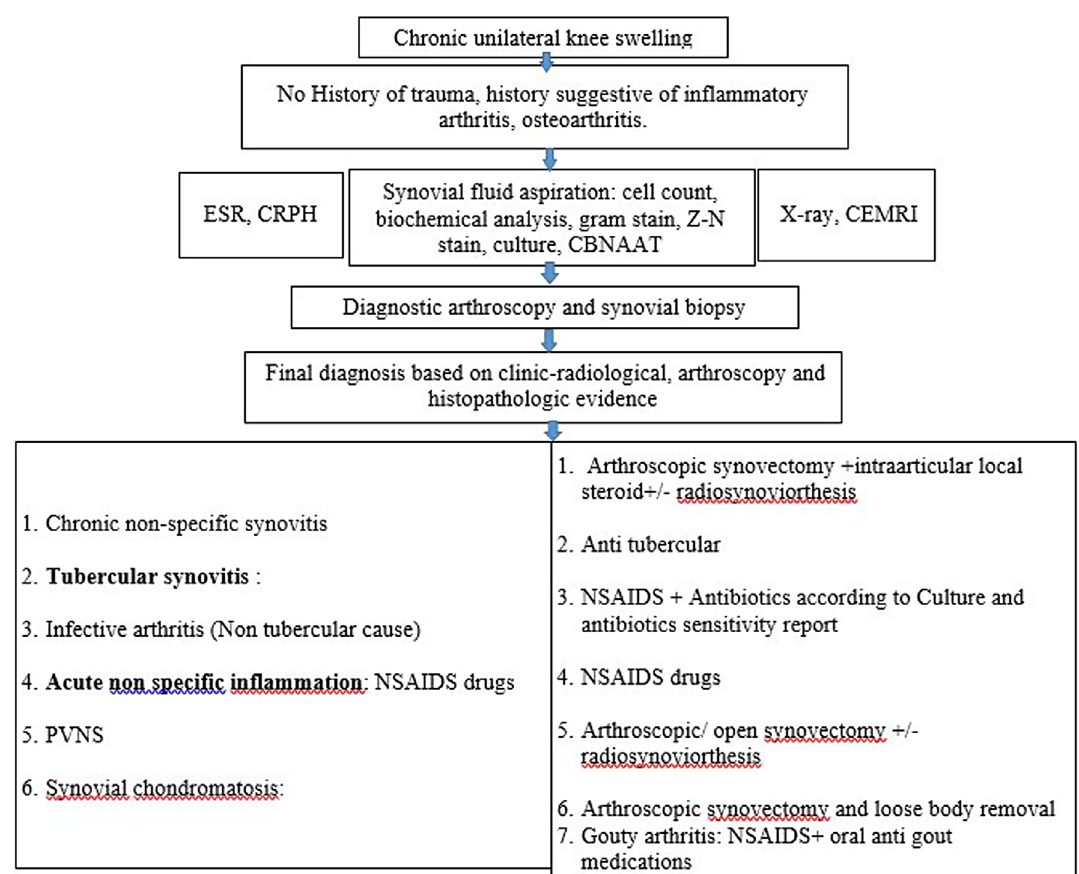
Figure 6. Flowchart showing treatment plan in chronic monoarticular